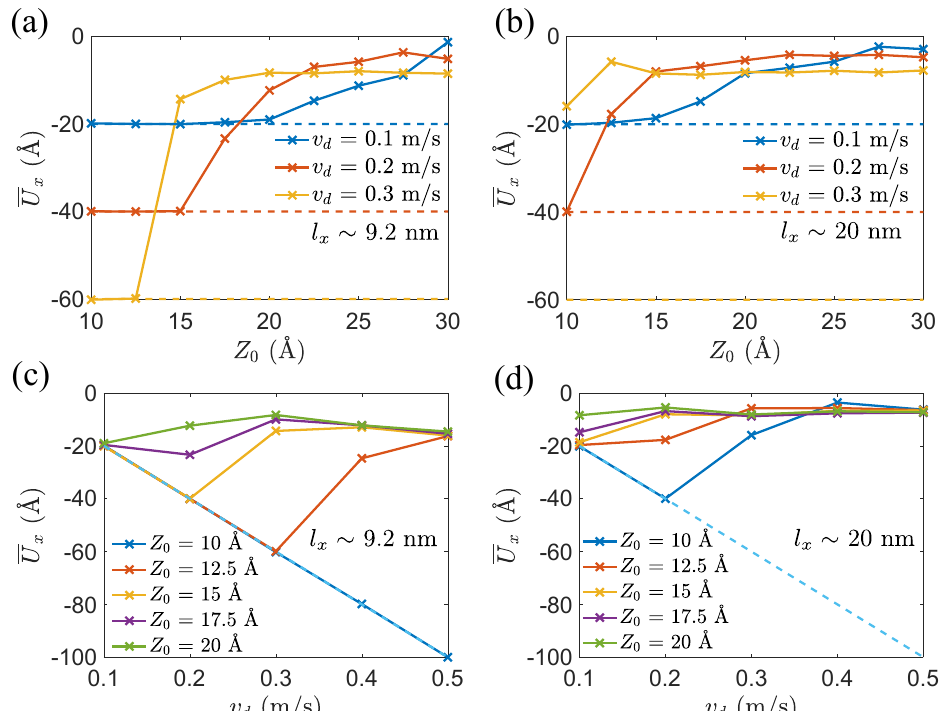
Figure 4. ( a , b ) Variations of displacement U x of tail atom with respect to lifting height Z 0 for different dragging velocities v d at time of 30 ns. Dotted lines represent the displacements of virtual atom; ( c , d ) variation of displacement U x of tail atom with respect to the dragging velocity v d for different lifting heights Z 0 at time of 30 ns. Dotted lines represent the displacements of virtual atom.